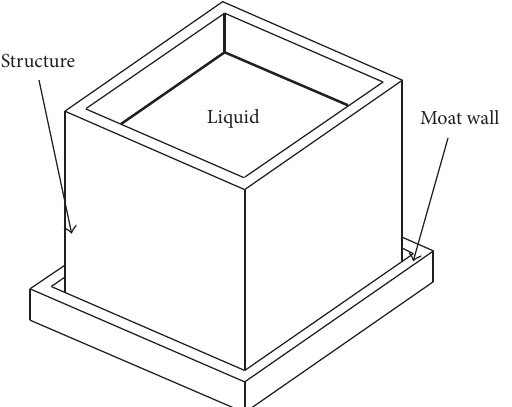
Figure 2: Sliding base-isolated concrete rectangular liquid-storage structure with moat